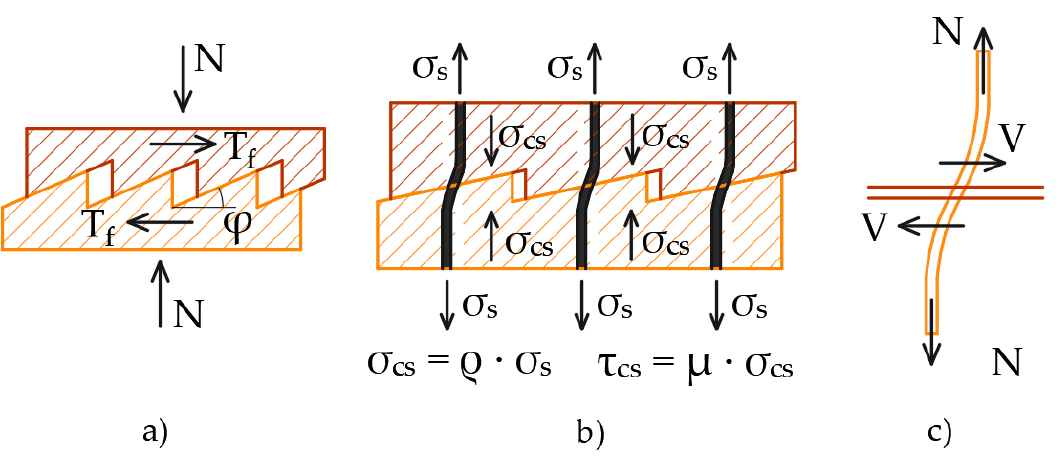
Figure 2. Shear mechanisms: ( a ) friction due to surface roughness and external compression; ( b ) friction due to connector clamping force; ( c ) dowel action. N (section ( a ))—external compressive force acting perpendicular to the interface. T f –shear force due to friction. σ s —tensile stress in the connectors. σ cs —resulting clamping stress. T cs —shear stress due to clamping force. M—friction coefficient. P—connector ratio. N (section ( c ))—tensile force acting on the connector. V—shear force acting on the connector.